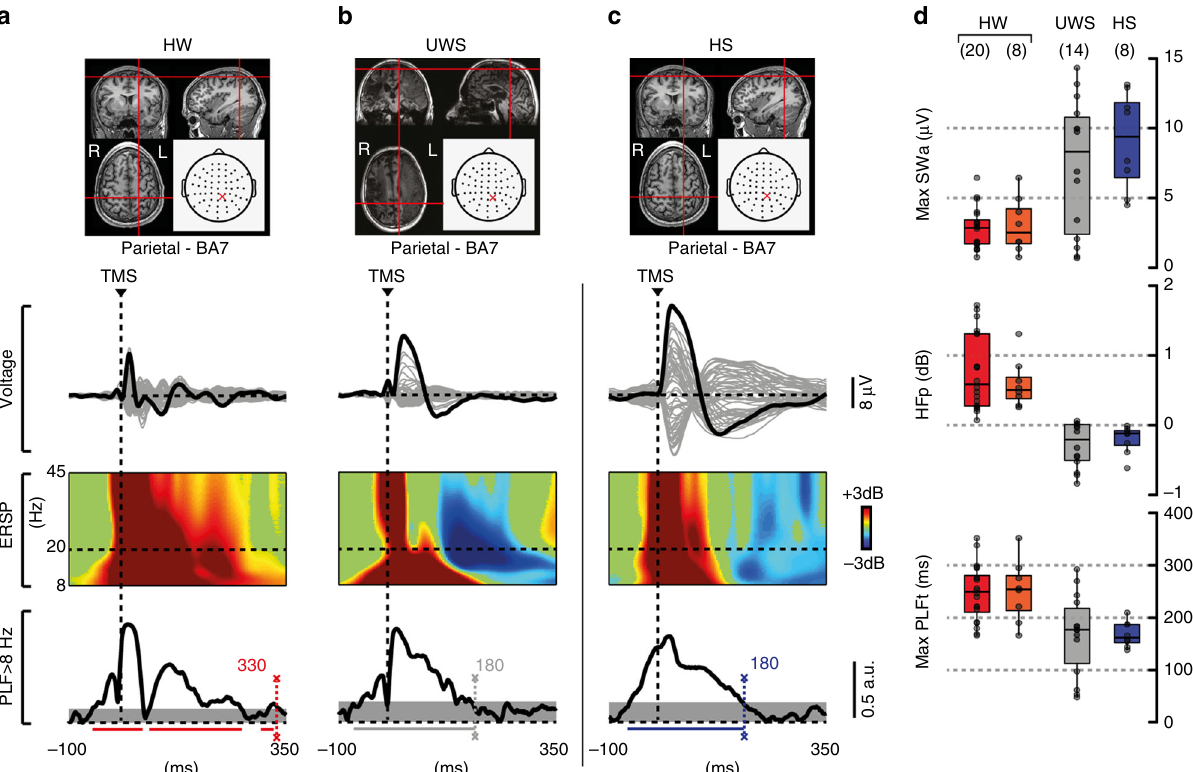
Fig. 1 TMS evokes a sleep-like OFF-period and an early drop of PLF in UWS patients. Results for a representative healthy subject during wakefulness (HW) and NREM sleep (HS) and a representative UWS patient (patient 11 in Supplementary Table 2) are shown for parietal stimulations (BA7). a – c MRIs and cortical targets as estimated by the Navigated Brain Stimulation system are shown (top). A dashed vertical line marks the occurrence of TMS. Butter fl y plots of the TMS-evoked EEG potentials recorded at all 60 channels (gray traces) are depicted. Event-related spectral perturbation (ERSP) and PLF are presented for the electrode with the larger response (black trace). In the ERSP plot, signi fi cance for bootstrap statistics is set at α < 0.05 (absence of any signi fi cant activation is colored in green): statistically signi fi cant increases of power compared to baseline are colored in red, while blue represents signi fi cant power decreases. The dashed horizontal line indicates the 20 Hz frequency bin. PLF time points above statistical threshold (gray shaded area) are indicated at the bottom by a colored horizontal line. The colored-dashed vertical line indicates the timing of the last signi fi cant ( α < 0.01) PLF time point. d From top to bottom, boxplots of slow wave amplitude (max SWa), high-frequency power (HFp), and duration of PLF (max PLFt) for HW (red and orange), HS (blue) and UWS (gray) are shown. Boxplot displays the median (center line), the fi rst and third quartiles (bounds of box). The whiskers extend from the bound of the box to the largest/smallest value no further than 1.5* inter-quartile range. Outlier datapoints are indicated by dots outside